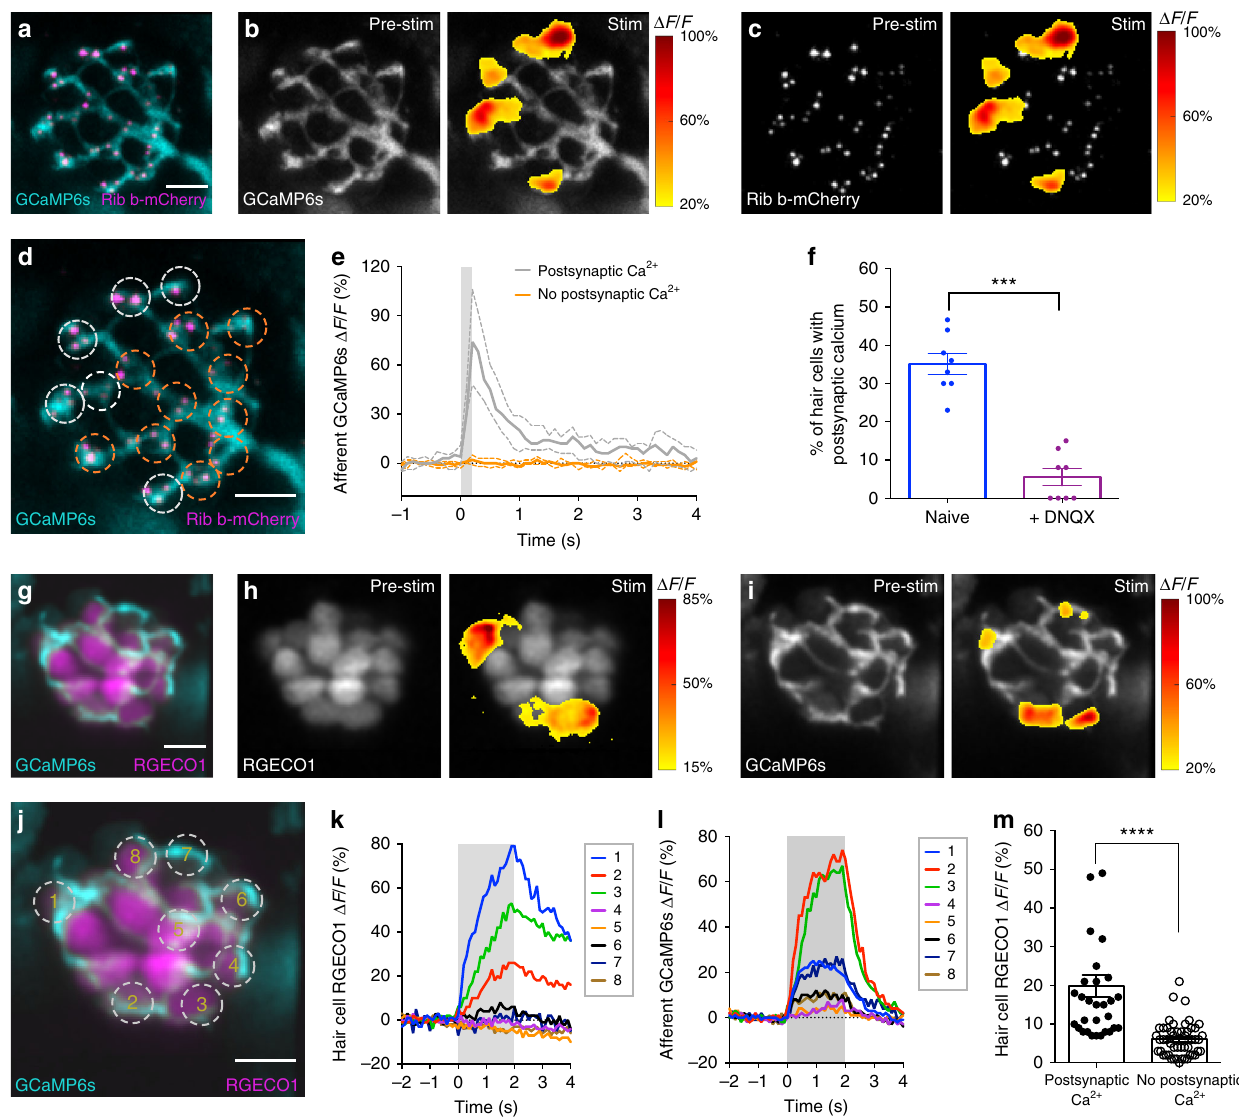
Fig. 3 Robust hair-cell Ca 2 + in fl ux corresponds with postsynaptic Ca 2 + responses. a A double transgenic line with afferent neurons expressing GCaMP6s- CAAX to detect postsynaptic Ca 2 + activity (cyan) and hair cells expressing Ribeye b-mCherry to label ribbons (magenta). b , c Representative neuromast demonstrating spatial patterns of afferent GCaMP6s signals during a 200-ms step stimulation (right panels). GCaMP6s signals correspond to the Δ F / F heat map and are superimposed onto the baseline GCaMP6s image ( b , left panel) or relative to presynaptic ribbons ( c , left panel). Only a subset of hair cells is associated with postsynaptic Ca 2 + activity. d Dashed circles indicate ROIs (diameter of 3 µ m) used to detect afferent Ca 2 + signals. e Plot of the postsynaptic Ca 2 + signals in the six cells with (white) and 10 cells without (orange) postsynaptic Ca 2 + activities (mean with upper and lower limits plotted). f The percentage of hair cells associated with afferent Ca 2 + activity (naive blue, 35% ± 2.76) is decreased after 10 µ M DNQX treatment (purple, 5.50 ± 2.24) to block postsynaptic AMPA receptors, n = 8 neuromasts, p < 0.0001. g Double transgenic with hair cells expressing RGECO1 (magenta) and afferent neurons expressing GCaMP6s-CAAX (cyan). h – l RGECO1 and GCaMP6s responses acquired from the same neuromast organ during a 2-s 5 Hz (anterior – posterior directed square wave) stimulus that activates all hair cells. Hair-cell RGECO1 ( h , right panel) or afferent GCaMP6s ( i , right panel) responses during stimulation are superimposed onto the baseline grayscale images ( h , i , left panels). j – l 10 ROIs (3 µ m) outlined in j were used to generate plots of the hair-cell RGECO1 Ca 2 + ( k ) or GCaMP6s afferent Ca 2 + ( l ) signals. Hair cells with strong Ca 2 + in fl ux (cells 1 – 3, k ) also have afferent Ca 2 + signals ( l ). m RGECO1 hair-cell Ca 2 + signals associated with afferent Ca 2 + signals (19.84% ± 2.38, n = 31 cells) were larger than those without (6.04% ± 0.62, n = 50 cells), p > 0.0001. A paired t -test was used in f , a Mann – Whitney test was used in m ; *** p < 0.001, **** p < 0.0001. Scale bars = 5 μ